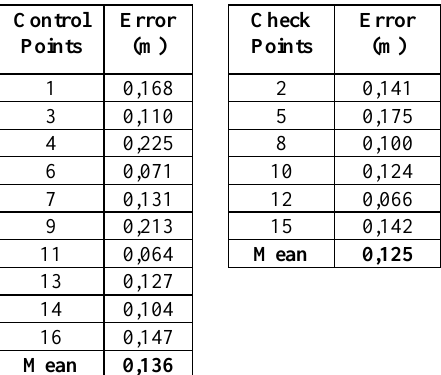
Table 3. Table of photogrammetric errors with respect to